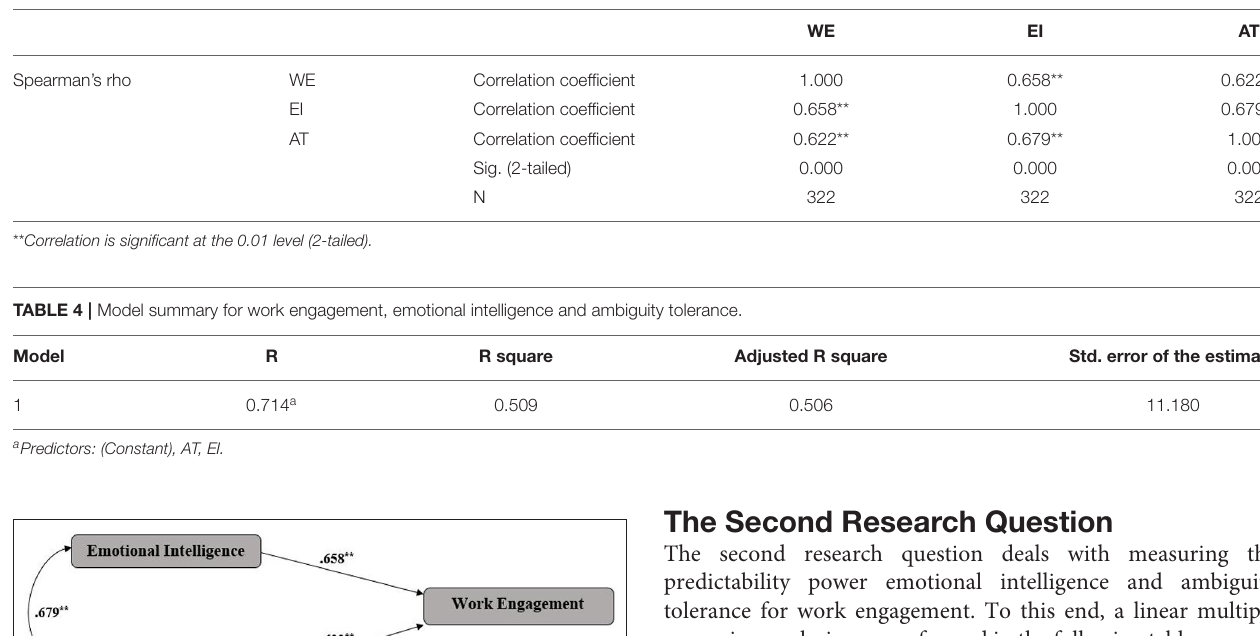
TABLE 3 | Correlations among work engagement, emotional intelligence, and ambiguity tolerance.